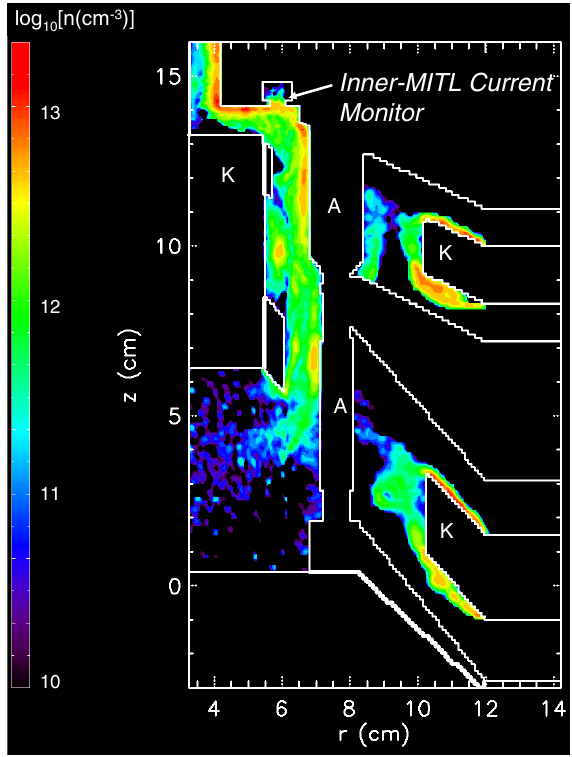
FIG. 3. (Color) Electron density plot illustrating the space- charge power flow in the convolute region with original inner- MITL current probe design at t ¼ 45 ns in the (cid:1) ¼ 0 plane. Anode (A) and cathode (K) parts are labeled.